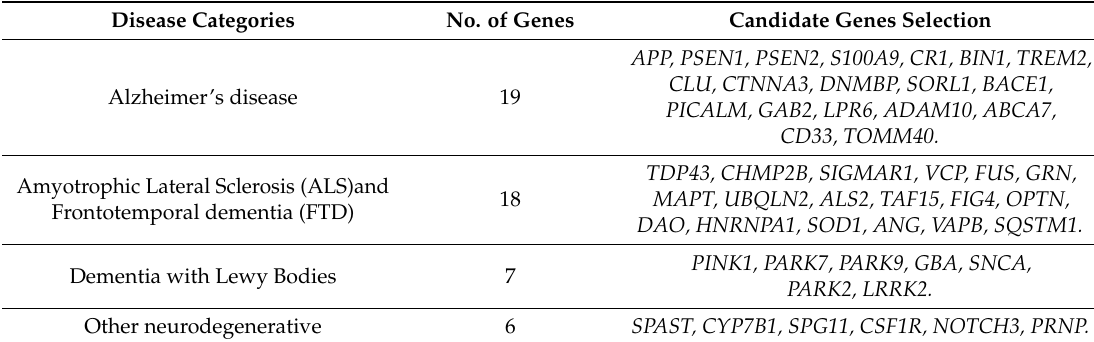
Table 2. List of 50 genes where causative or probably causative variants were reported to cause early-onset